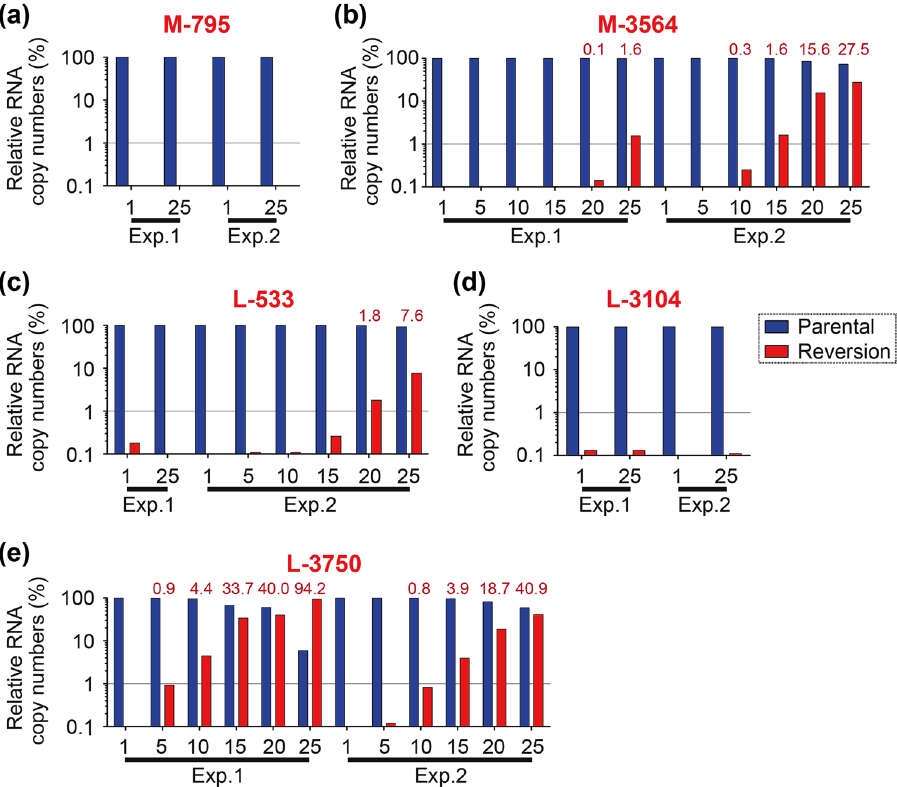
Fig. 5 Detection of reversion mutants of rMP12- Δ NSs16/198 during passages in Vero cells. Recombinant MP-12 encoding a 69% in-frame truncation of NSs open reading frame (rMP12- Δ NSs16/198) was passaged 25 times in Vero cells at MOI of 0.01 or less at 3 days post infection. The presence of reversion mutations are shown. a M-segment nt. 795: HEX-795-C and FAM-795-T, b M-segment nt. 3564: HEX-3564-G and FAM-3564-A, c L-segment nt. 533: HEX-533-C and FAM-533-T, d L-segment nt. 3104: HEX-3104-A and FAM-3104-G, and e L-segment nt. 3750: HEX-3750-A and FAM-3750-G. Two independent studies are shown (Exp-1 and 2). Relative percentages of RNA copy numbers for parental and reversion mutants are shown in blue and red bars, respectively. The bar labels in red represent the percentages of reversion